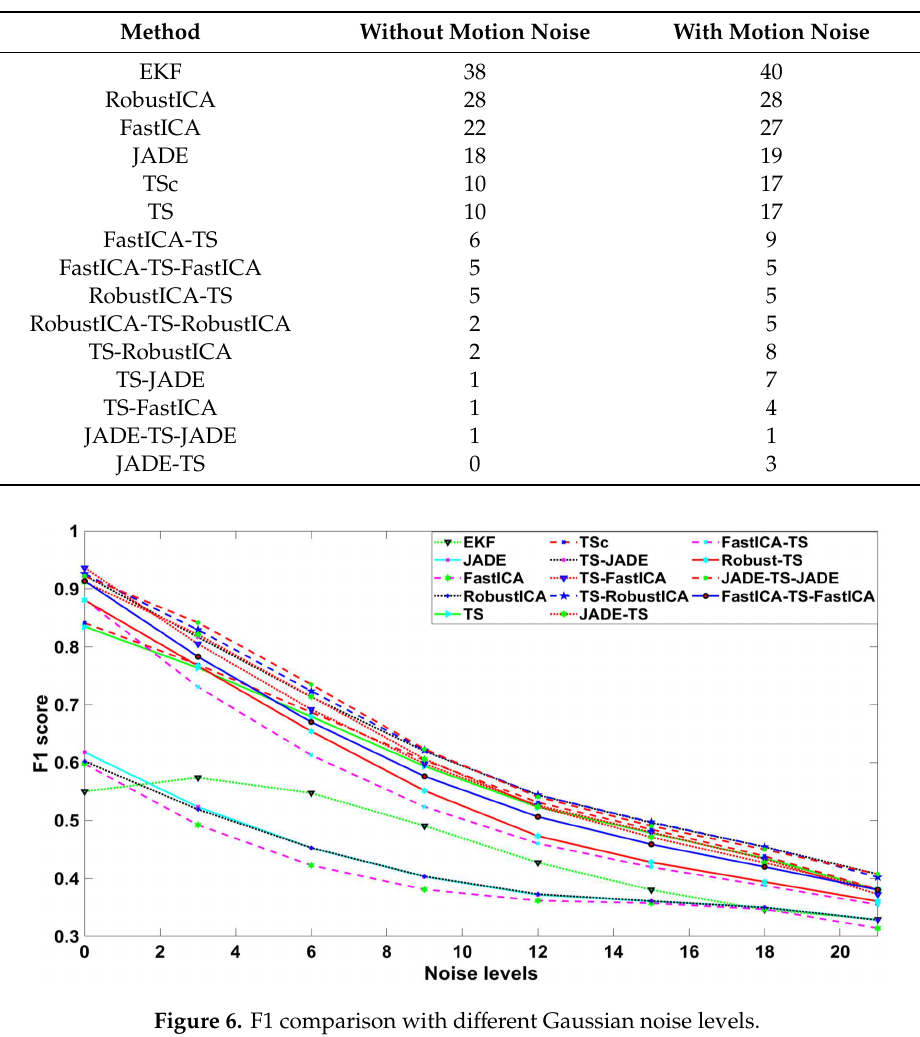
Figure 6. F1 comparison with di ff erent Gaussian noise levels. Table 3. Required memory for di ff erent